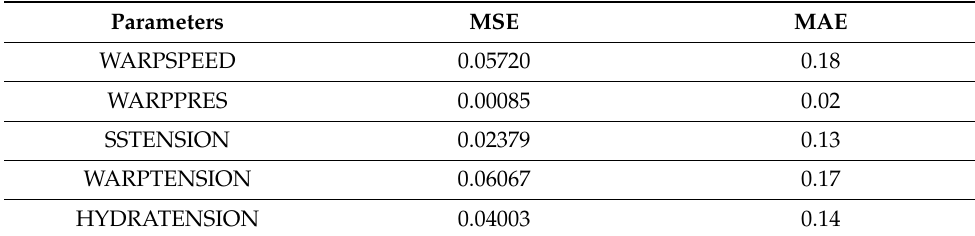
Table 8. Lasso regression results for the warping process.